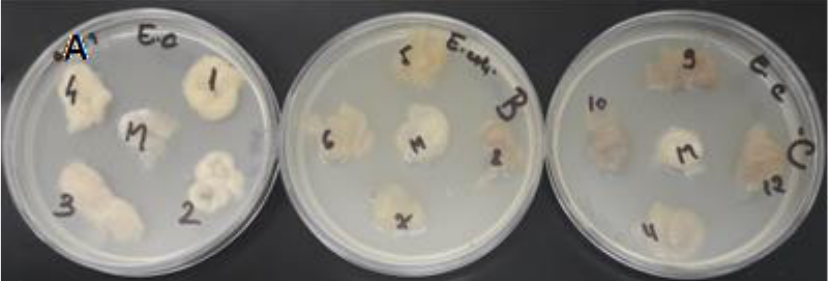
Figure 16. Antimicrobial activity of wool samples against Escherichia coli ATCC 25922: A — wool samples treated with citric acid; B — UV-irradiated wool samples; C — untreated wool samples; 1 — wool dyed with aqueous extract, 2 — wool dyed with ultrasonic extract; 3 — wool dyed with alcohol extract; 4 — wool dyed with acid extract, M — control.